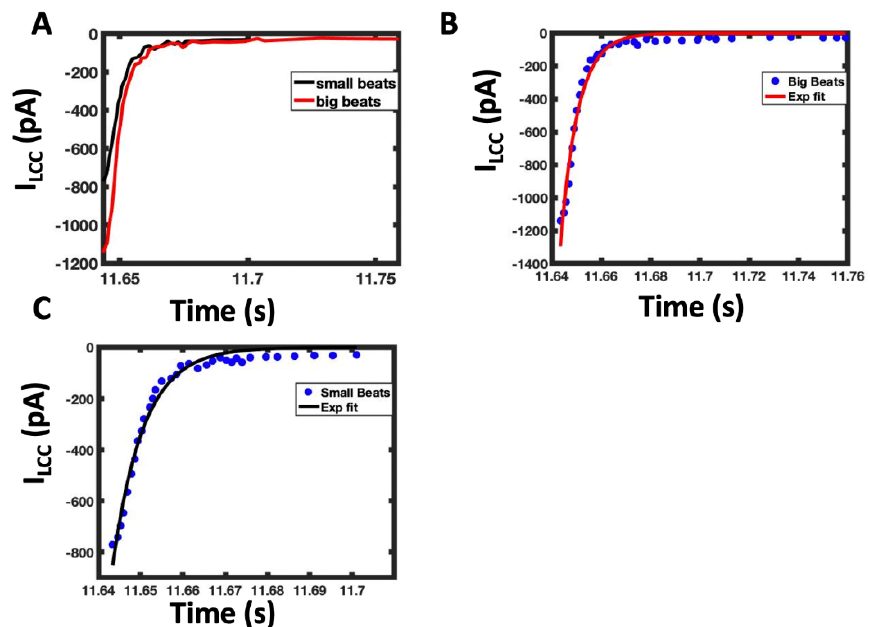
Figure A6. Ca 2+ -dependent inactivation of the L-type channel occurs at different rates in large and small beats during alternans. ( A ) The decay in the L-type Ca 2+ current for large (red) and small (blue) beats. ( B ) Fitting an monoexponential curve (f(x) = a × exp( − x/b)) to the decay yielded a = − 9.37 pA and b = 0.21 s for the large beat with a R2 = 0.977. ( C ) Fitting an monoexponential curve (f(x) = a × exp( − x/b)) to the decay yieldeda = − 55.8 pA and b = 0.46 s for the small beat with a R2 = 0.980, re- spectively.